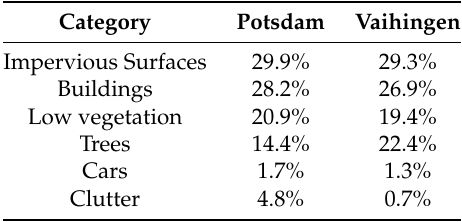
Table 1. Percentage of each category in the